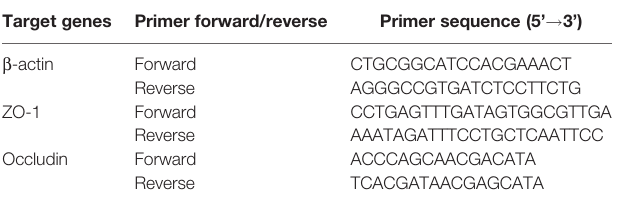
TABLE 2 | Primer sequences